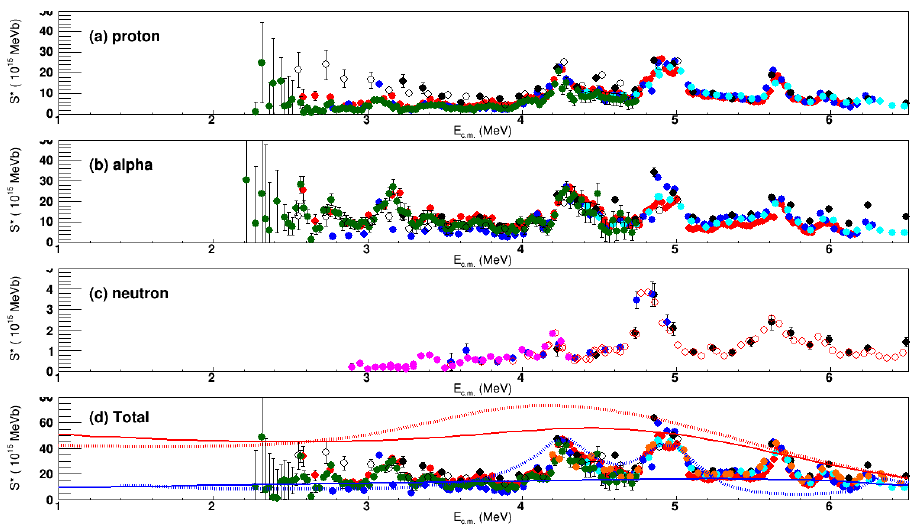
Figure 4. (Color online) The modified S factors of the proton, alpha, neutron channels and their sum are shown as (a), (b), (c) and (d), respectively. The branching ratio corrections have been applied. The explaination of legends can be found in Ref.